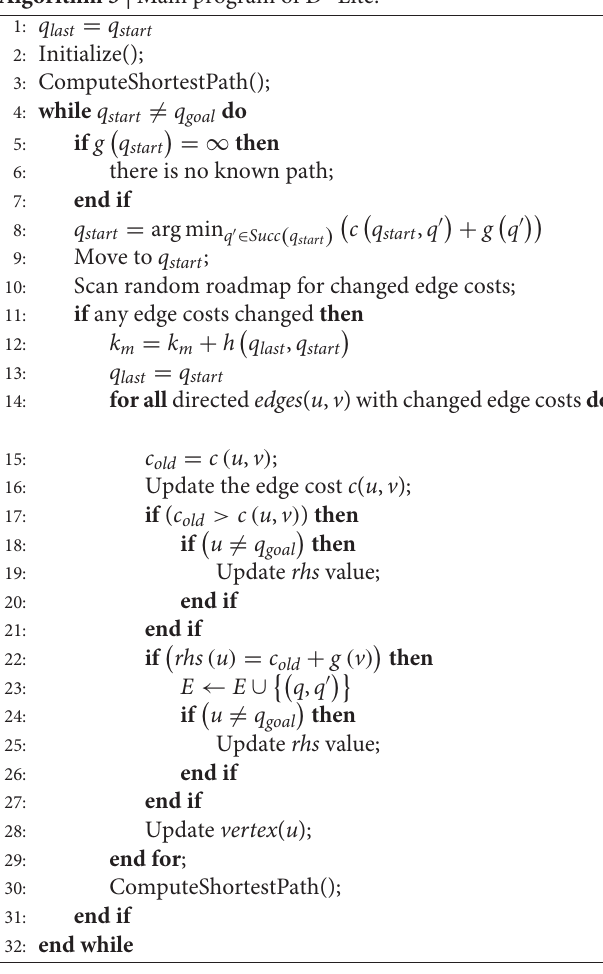
algorithm does not need to completely replan the path, while obstacle avoidance. The D* Lite method is given in Algorithm 3 and readers who are interested in the algorithm can refer (Koenig and Likhachev, 2005). Note that heuristic solutions are mostly near-optimal solutions with the trade off computational efficiency.